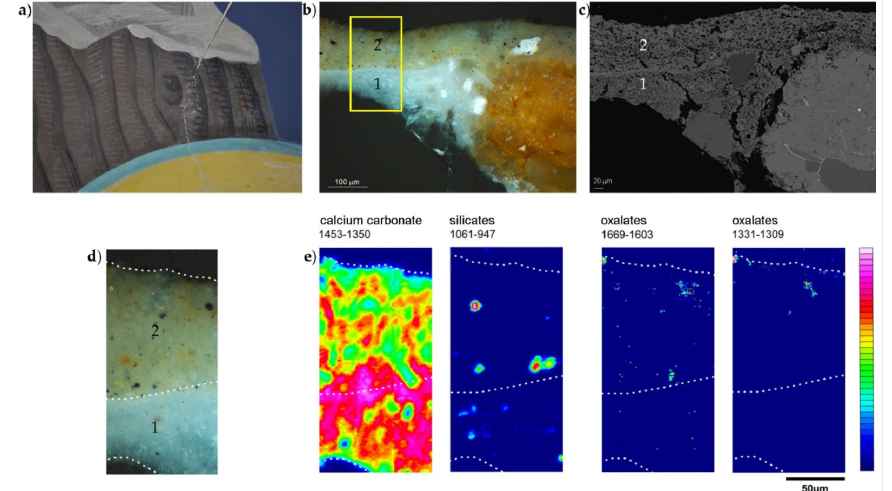
Figure 11. ( a ) Image of the sampling area (image size ca. 35 × 20 cm) along a fracture in the tree trunk behind the figure of Saint Sebastian; ( b ) optical microscope and ( c ) SEM-BSE images of the cross- section of the micro-sample collected in ( a ); ( d ) area analyzed by FTIR-FPA imaging (the location is shown in ( b ) with a yellow rectangle); ( e ) FTIR-FPA imaging results with integration of the following spectral range: 1453–1350 cm –1 (calcium carbonate); 1061–947 cm –1 (silicates); 1669–1603 cm –1 and 1331–1309 cm –1